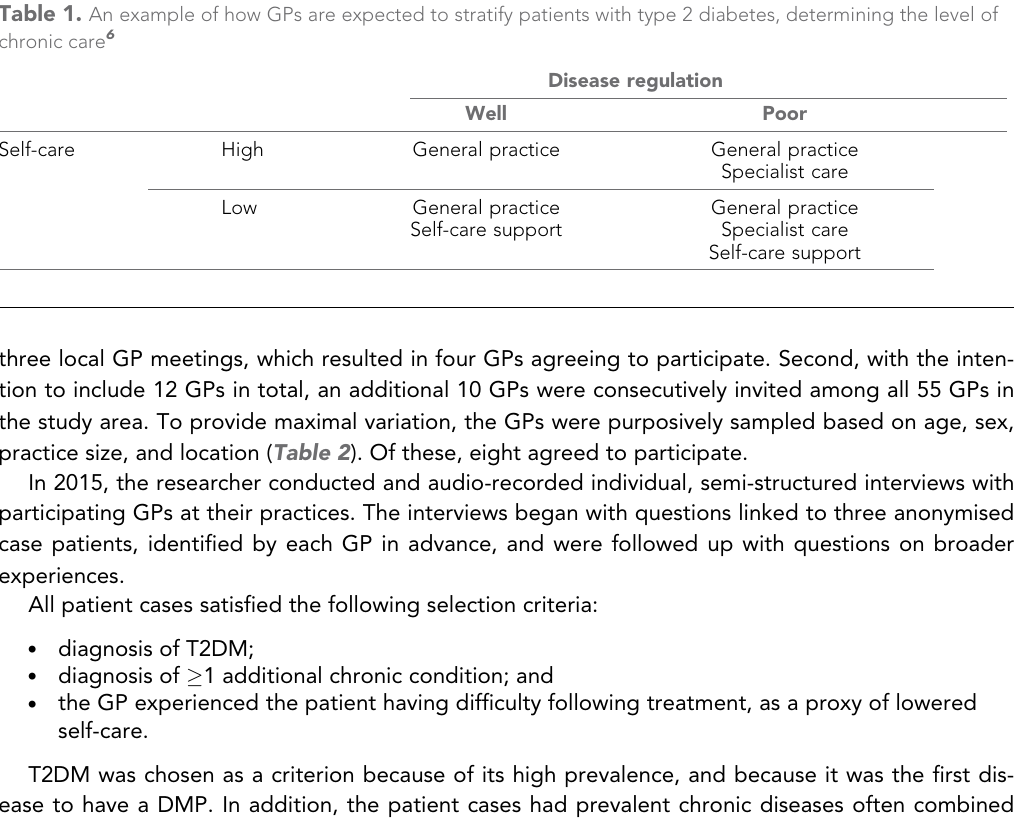
Table 1. An example of how GPs are expected to stratify patients with type 2 diabetes, determining the level of